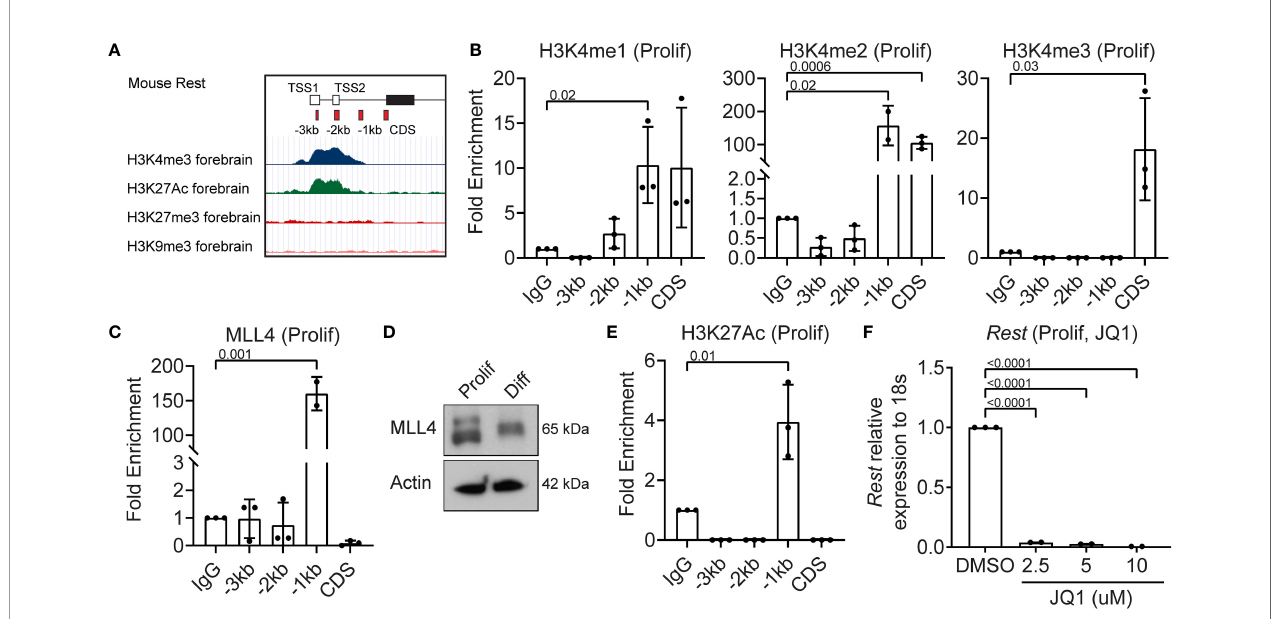
FIGURE 2 | MLL4 activity is associated with transcriptional activation of REST in proliferating CGNPs. (A) Schematic of Rest locus in mouse showing H3K4me3 and H3K27me3 in the cerebellum and representing primer design strategy to include CDS and upstream promoter at -3kb, -2kb and -1kb. (B) H3K4me1,2 and 3 levels were measured by ChIP-qPCR and plotted as fold enrichment over IgG in proliferating progenitors. (C) ChIP-qPCR showing enrichment of MLL4 at the Rest promoter represented as fold change over IgG. (D) Western blot analysis of MLL4 protein and Actin from proliferating and differentiating progenitors. Shown is a representative blot from n = 2. (E) H3K27Ac was measured by ChIP-qPCR in proliferating progenitors and plotted as fold enrichment over IgG (n = 4 for proliferating progenitors). (F) Effect of BRD4 inhibition with JQ1 on Rest mRNA was shown by qRT-PCR in DMSO and JQ1 treated progenitors in proliferating and differentiating conditions (n =